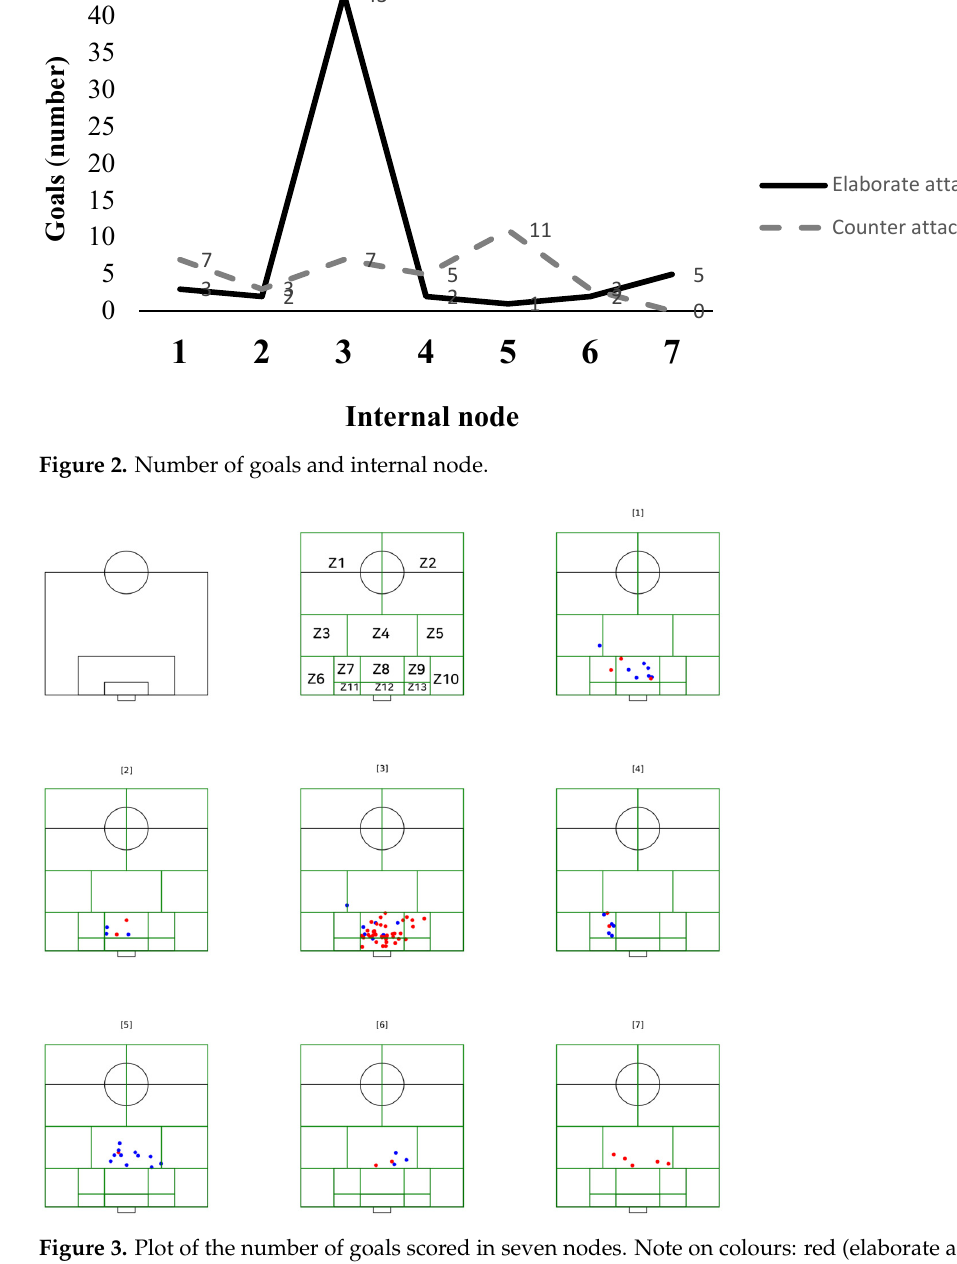
Figure 3. Plot of the number of goals scored in seven nodes. Note on colours: red (elaborate attacks) and blue (counterattacks).